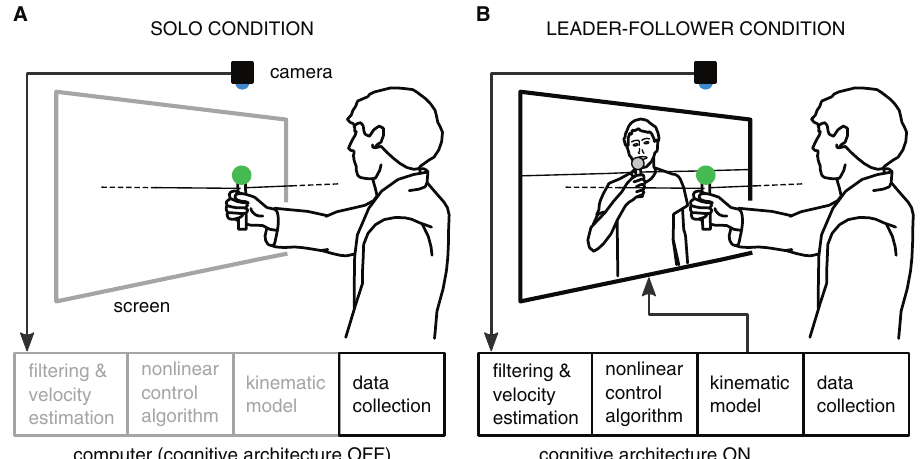
Fig. 1 Illustration of the main experimental set-up and of the experimental conditions. a Solo condition of the mirror game, hand movement of the participant along a line is recorded on a computer. b In the leader – follower condition participant is following motion of a computer avatar that is displayed on the